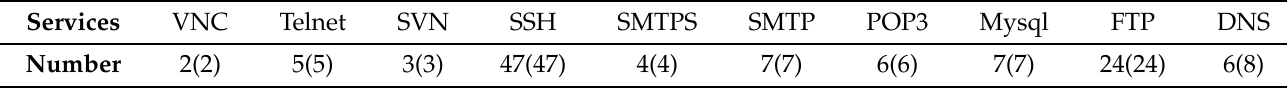
Table 12. Manual verification for network asset identification by WebHunt.